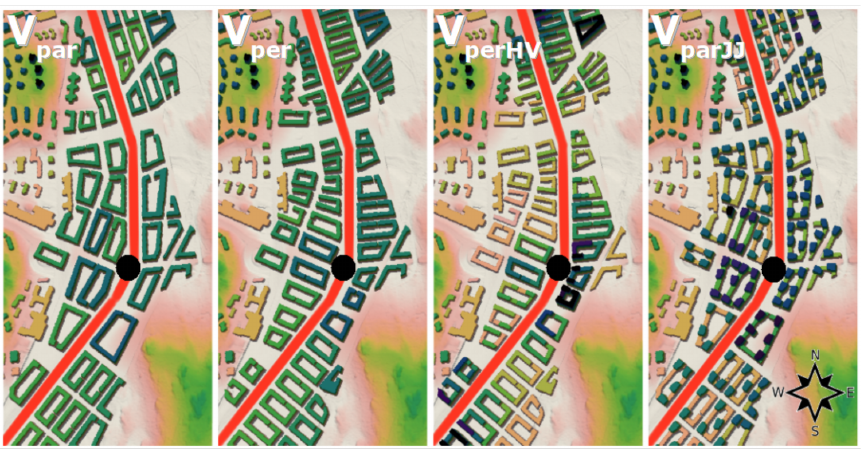
Figure 1. The city-block-design alternatives. From left to right: V par (the longer sides of buildings parallel to the boulevard), V per (the longer sides perpendicular to the boulevard), V perHV (similar to V per but the building height varies) and V parJJ (similar to V par but with Jing-Jang building structure variation). The boulevard is marked in red and the major junction with a black dot.